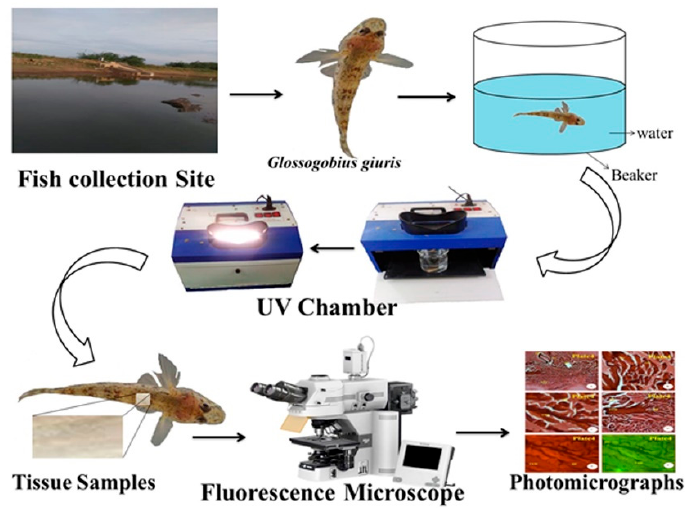
Figure 1. The flow diagram for the transportation of G. giuris from its capture to the laboratory. A single fish was transported in a large fish tank per journey in order to make sure that no stress was suffered by any fish.